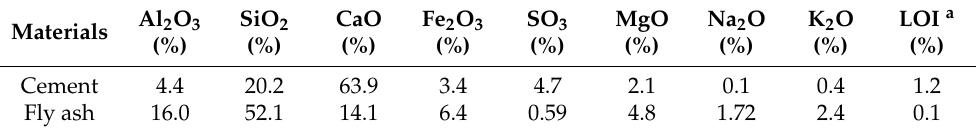
Table 2. Chemical Composition of Portland cement and fly ash (by mass).